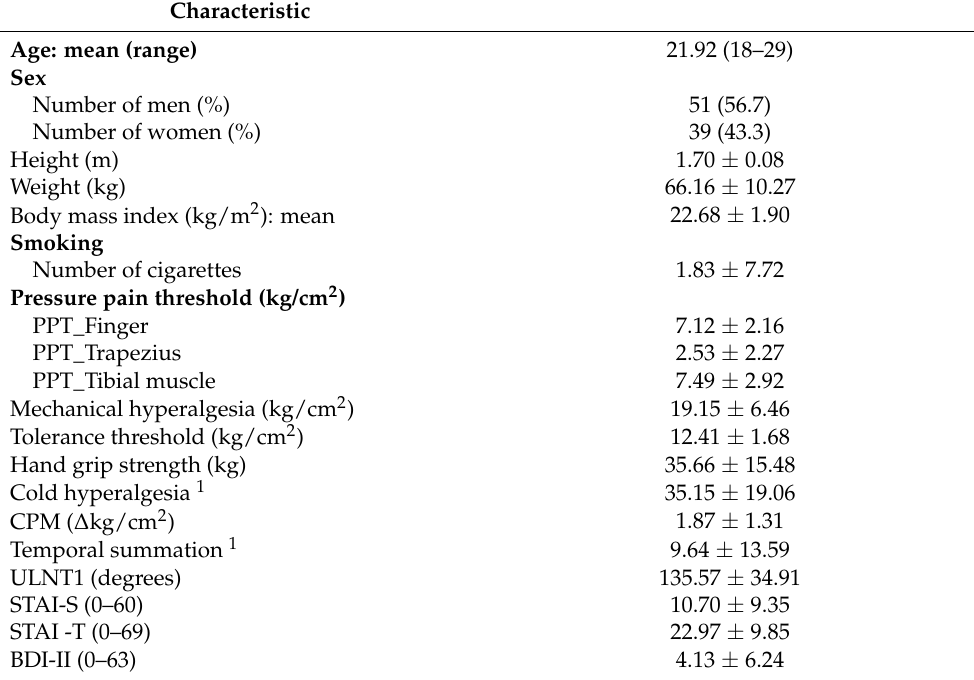
Table 1. Demographic, pain and mood characteristics of recruited participants at